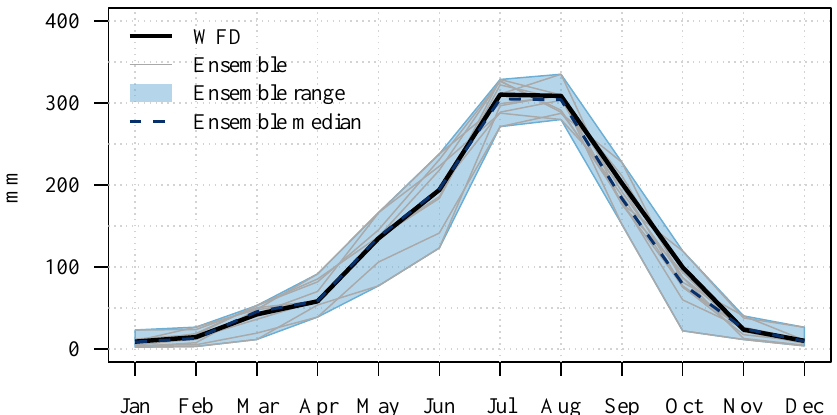
Figure 2. Average monthly precipitation in the historical period (1970–1999) of Watch Forcing Data (WFD) and the 10 climate models (ensemble) used in this study.